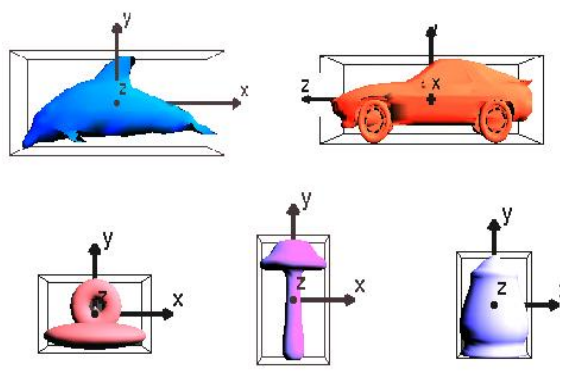
Figure 2. Example Object Models for